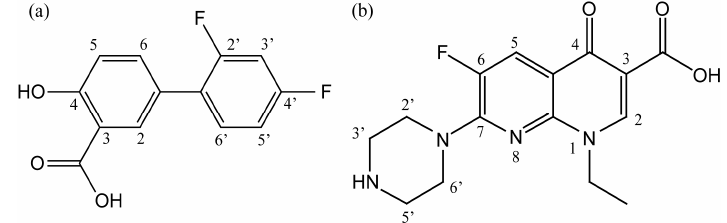
Figure 1. The structures of ( a ) diflunisal and ( b ) enoxacin.